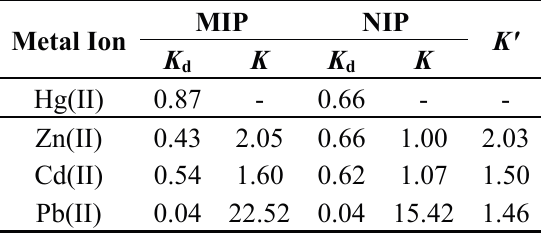
Table 3. K d , K , and K' values of Zn(II), Cd(II) and Pb(II) with respect to